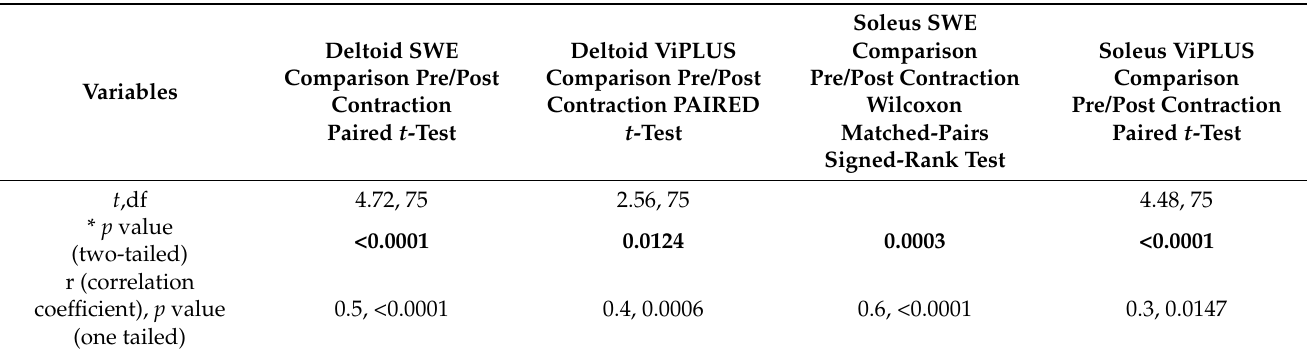
Table 3. Paired group comparisons of elastographic and viscosity values between the pre- and